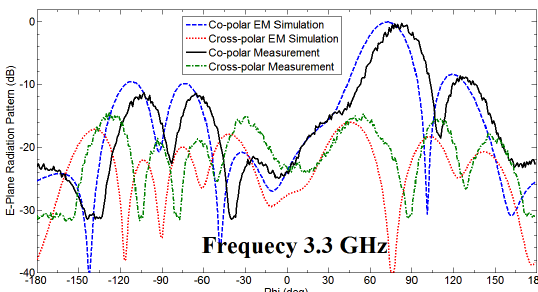
Figure 6. Normalized E-plane pattern of the developed antenna array having fan beam at 3.30 GHz.